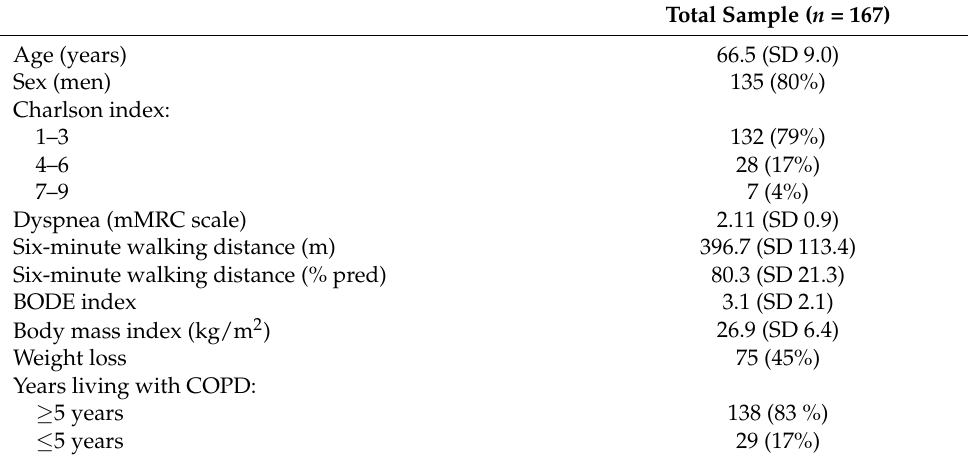
Table 1. Baseline description of participants ( n =